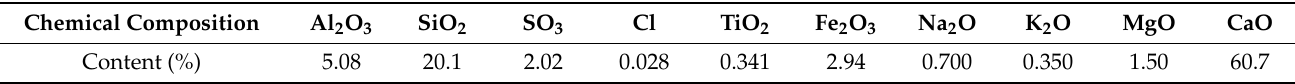
Table 1. Chemical composition of cementitious materials.